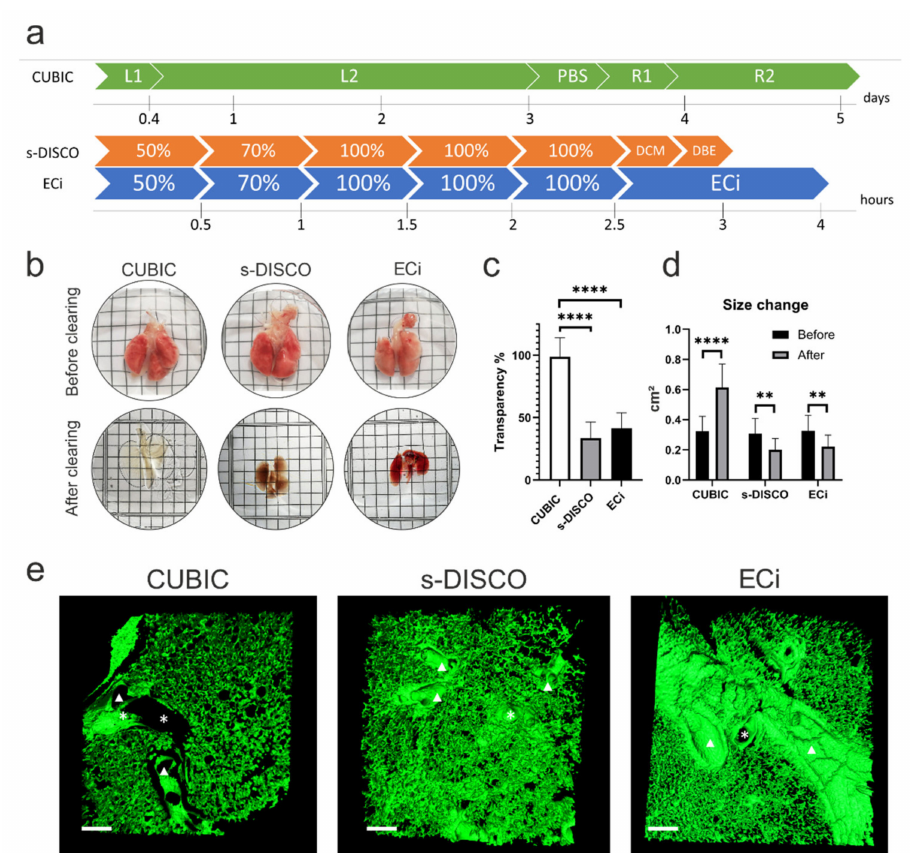
Figure 2. Comparison of the effect of different clearing methods on lung tissue. ( a ) Timeline required to clear whole lungs using each protocol. L1 = Delipidation and decolourisation cocktail 50% ( v / v ). L2 = Delipidation and decolourisation cocktail 100%. R1 = RI matching cocktail 50% ( v / v ). R2 = RI matching cocktail 100%. Percentages in s-DISCO and ECi represent the solvent concentration. ( b ) Representative images of lungs before (top row) and after (bottom row) optical tissue clearing. Each line of a square represents 2 mm. ( c ) Quantification of transparency of lung samples after optical tissue clearing One-way ANOVA with Tukey’s multiple comparisons test **** p < 0.0001. n = 3. ( d ) Size change (area cm 2 ) in single lung lobes before and after each tissue-clearing method was evaluated using multiple paired t -tests ** p < 0.01, **** p < 0.0001, n = 3. ( e ) Three-dimensional variable threshold intensity surface reconstruction of lung sections cleared by the different protocols. blood vessels (indicated by asterisks (*)) and airways such as bronchi (indicated by arrowheads)